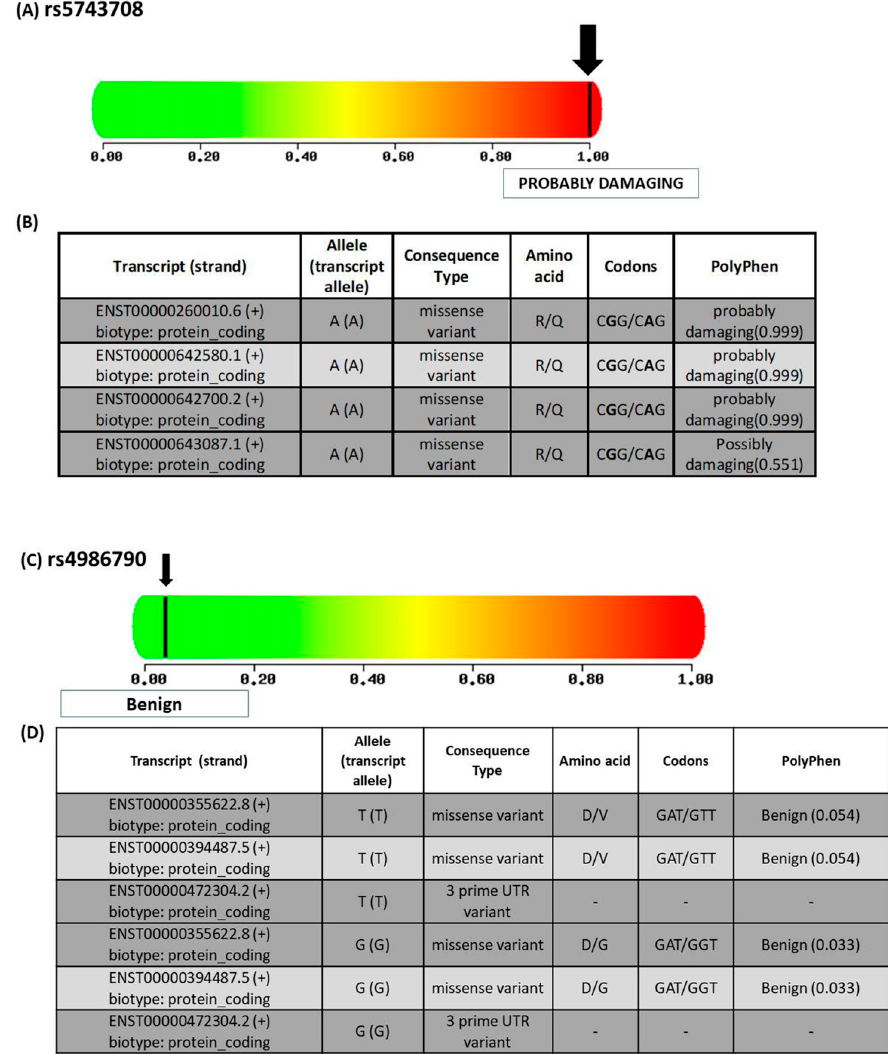
Figure 3. Functional and structural consequences of SNPs ( A ). Predicting the impact of rs5743708 on TLR2 function—the score ranged from benign (0) to damaging (1) ( B ). Table showing the transcripts of rs5743708, allele (transcript allele), consequence type, amino acid fate, codons, and PolyPhen score. R: Arginine, Q: Glutamine (ensemble.org). ( C ) Predicting the impact of rs4986790 on TLR4 function the score ranges from benign (0) to damaging (1) ( D ). Table showing the transcripts of rs4986790, allele (transcript allele), consequence type, amino acid fate, codons, and PolyPhen score. D: Aspartate, V: valine, G: Glycine (ensemble.org).